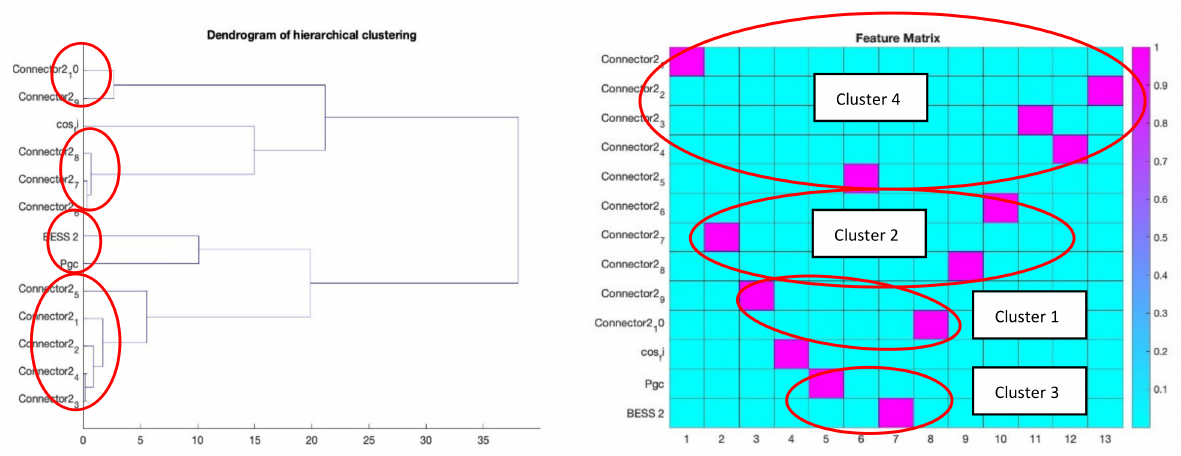
Figure 10. Analysis of the characteristics and their links. Operation system—BESS 2. The red circles in the figure indicate clusters of data features.